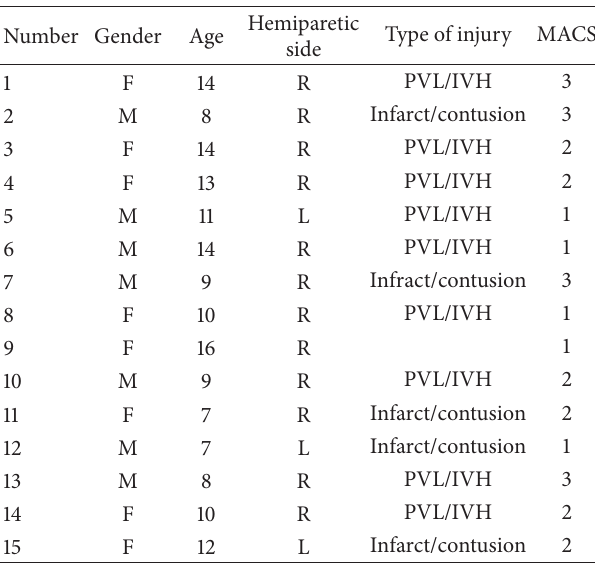
Table 1: Subject characteristics.